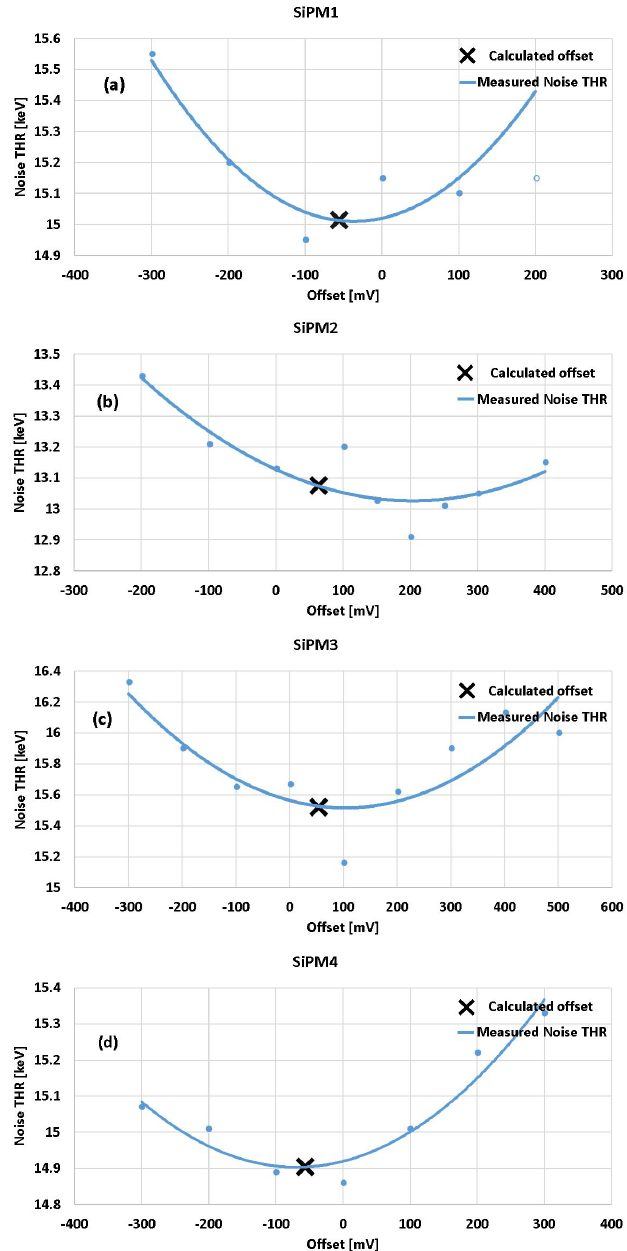
Fig. 7.Noise threshold as a function of the offset voltage for SiPM1 (a), SiPM2 (b), SiPM3 (c), and SiPM4 (d). The 'X' marks the correlating value from Table Ⅱ .